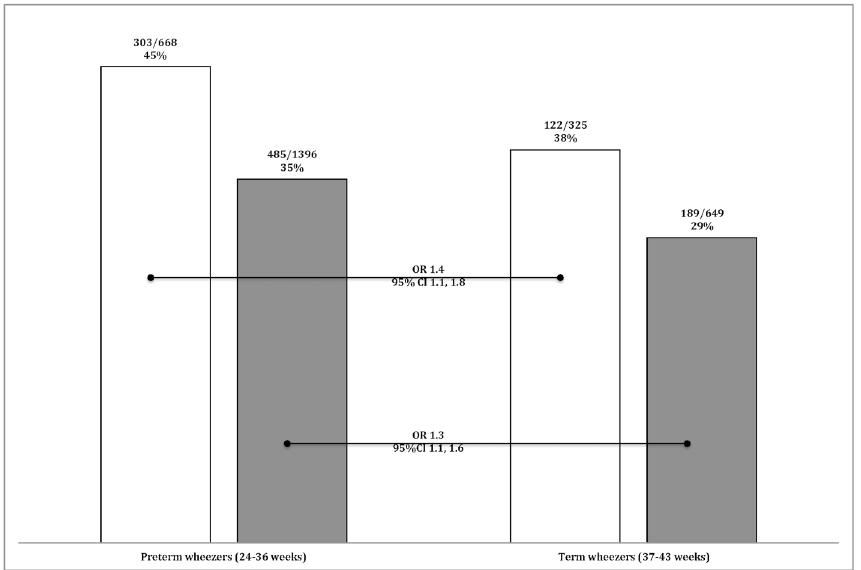
Fig 3. Prevalence of inhaler treatment amongst wheezing children. Bars denote the percentage of wheezy children being treated with inhalers who have a family history of atopy (white bars) or not (black bars) and for both gestational groups, preterm or